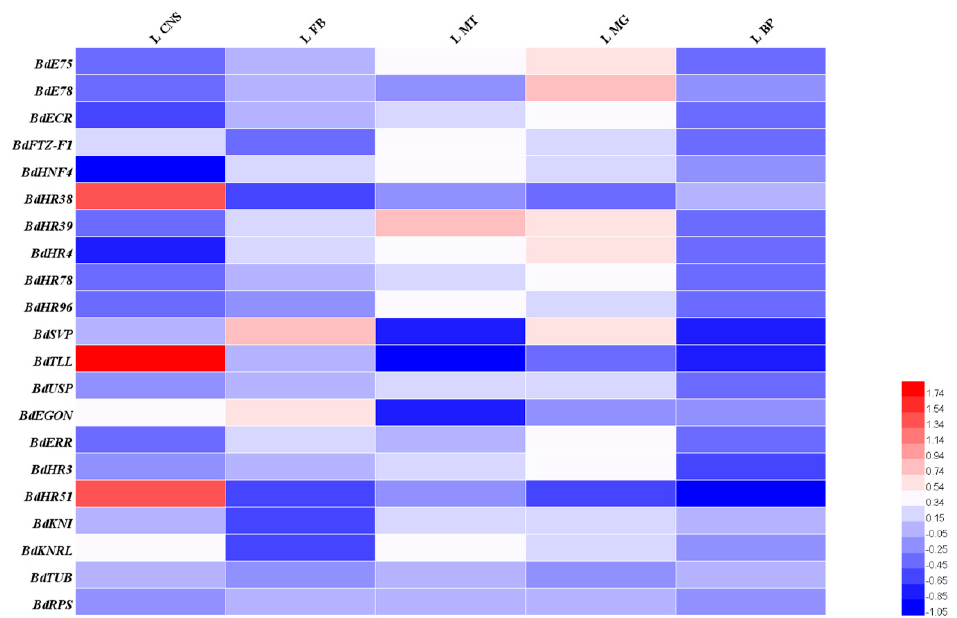
Insects 2019 , 10 , x FOR PEER REVIEW 8 of 16 Figure 4. Tissue-specific expression of 19 B. dorsalis NR genes (excluding BdHR83 and BdDSF ) from four-day-old adults. Relative transcript levels were calculated using α -tubulin (GenBank Accession no.: GU269902) and rps3 (GenBank Accession no.: XM_011212815) as internal references. Three to four independent biological replicates and two technical replicates were performed for each qRT-PCR. Midgut of female/male adults (F/M MG); fat body of female/male adults (F/M FB); Malpighian tubule of female/male adults (F/M MT); ovary of adult females (OV); testis of adult males (TE). Warm colors (i.e., red) indicate high expression levels and cold colors (i.e., blue) indicate low expression levels.